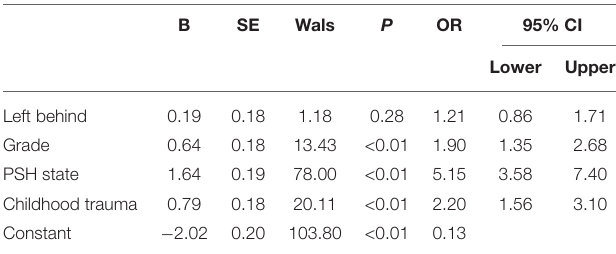
TABLE 4 | Risk factors for NSSI ( n = 778).